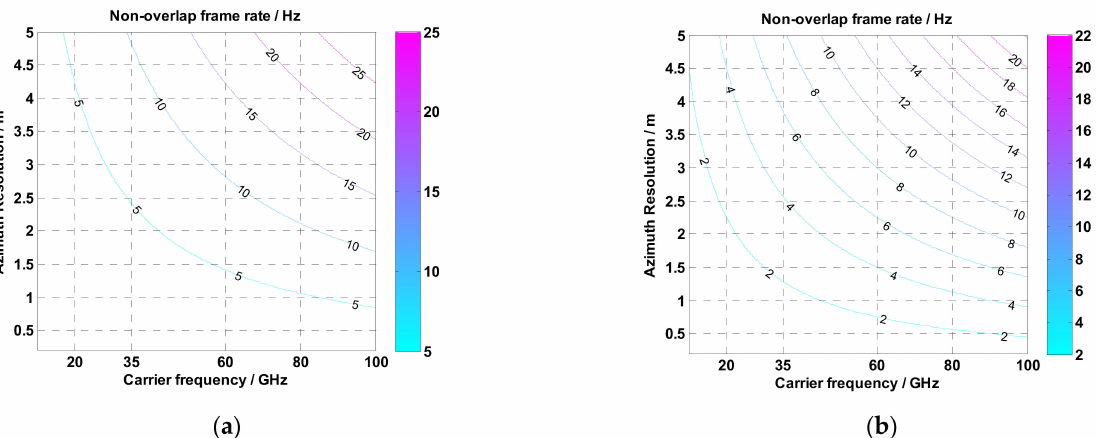
Figure 3. Non-overlap frame rate results of typical spaceborne ViSAR system with velocity of 7271 m/s and scene center slant range of 820 km. ( a ) squint angle equals to 0 degree. ( b ) squint angle equals to 30 degrees. The unit of the color bar is hertz.